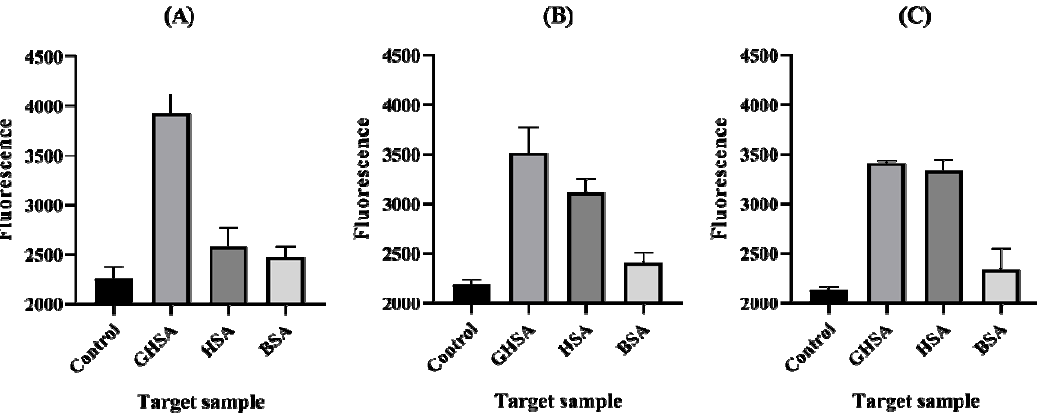
Figure 3. Specificity test of aptamer candidates with fluorescence signal. Albumins GHSA, HSA, and BSA were used to compare the signals: ( A ) GABAS-01, ( B ) GABAS-02, and ( C ) GABAS-03.